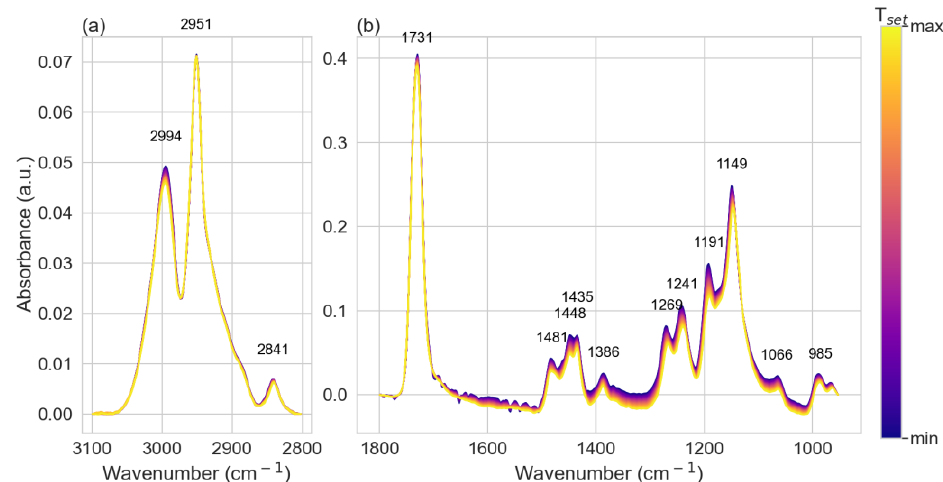
Figure 2. Infrared absorption spectra of PMMA measured with variable temperature from 283 and 373 K in 3 K steps. ( a ) All spectra have been baseline corrected in the region of the C-H vibrational peaks between 3100 and 2800 cm −1 and ( b ) the fingerprint region between 1800 and 950 cm −1 . Table 1. Peak assignment of the measured PMMA absorption peaks compared to literature values at room temperature.